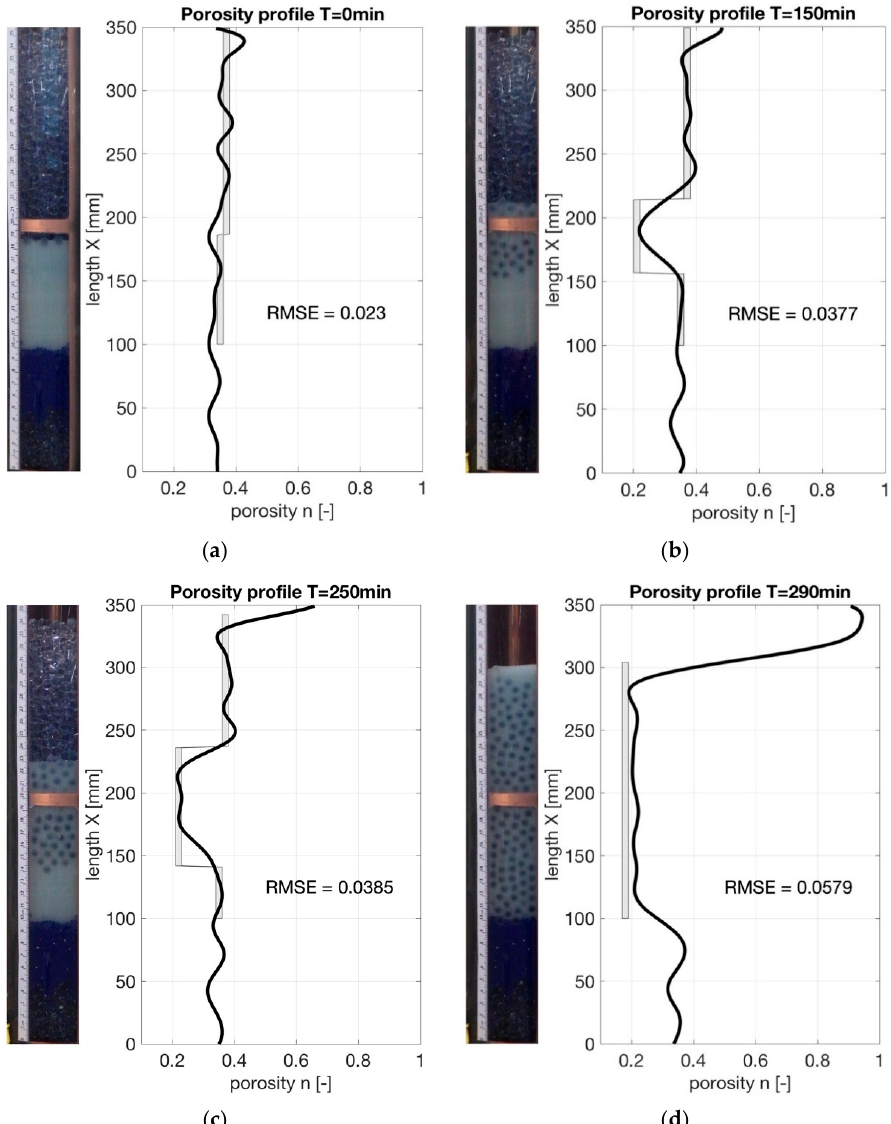
Figure 11. Comparison of porosity profiles determined with a TDR approach (black) and computed from layer heights (grey) at different time steps of the erosion experiment: ( a ) initial state; ( b ) after 150 min; ( c ) after 250 min, ( d ) after 290 min at the end of the test run.